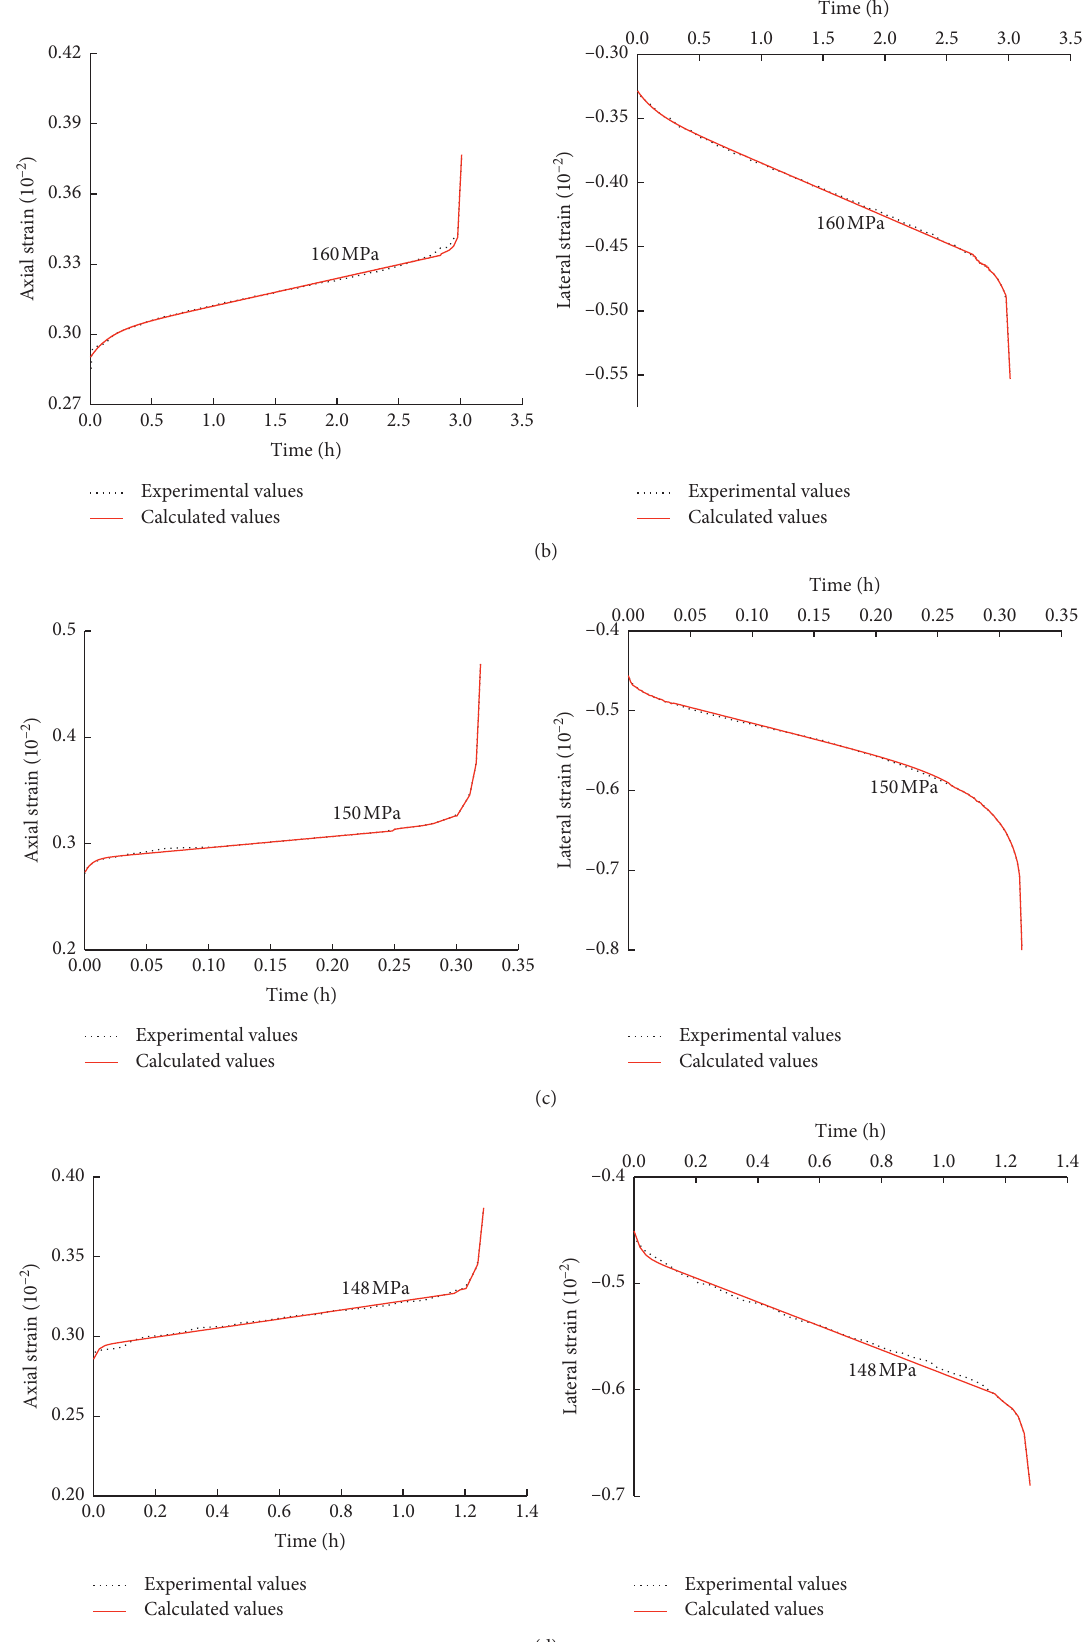
Figure 6: Relationships between the experimental and the calculated values at the failure stress level. (a) 0 th cycle. (b) 2 nd cycle. (c) 6 th cycle. (d) 10 th